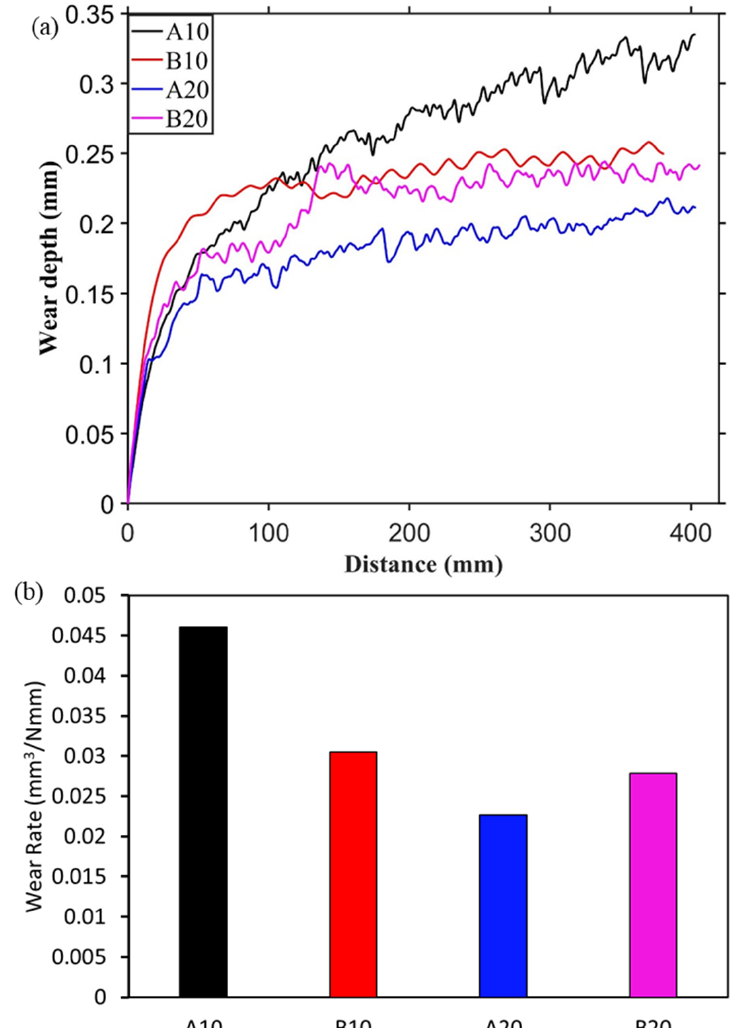
Figure 5. Wear measurement against steel ball. ( a ) Wear depth during sliding and ( b ) final wear rate. The observed coe ffi cient of friction (COF) variations over the distance against alumina ball and steel ball are shown in Figure 6a,b, respectively. Against alumina ball, the lowest COF at the end of the test was observed for A10 composite (that is, 0.42); COF increased gradually, and the highest COF of 0.75 was observed for B20 composite. This COF trend is related to the phases present in the composites. As shown in XRD results (Figure 2), h-BN was present in the composite, which is a solid lubricant material used to lower the COF. However, the presence of aluminum borate lowered the h-BN amount in the matrix. This relative amount of h-BN and aluminum borate suggests the observed trend in COF against alumina ball. The average COF for pure alumina sample against alumina ball and steel ball was 0.83 and 0.81, respectively, which was higher than all the